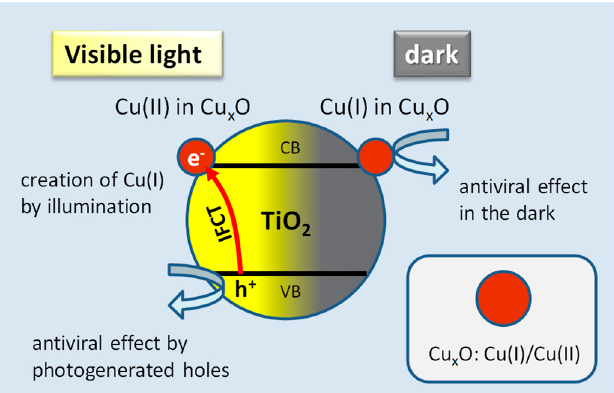
Figure 15. Schematic illustration of the working principle of the antiviral Cu x O / TiO 2 photocatalyst.